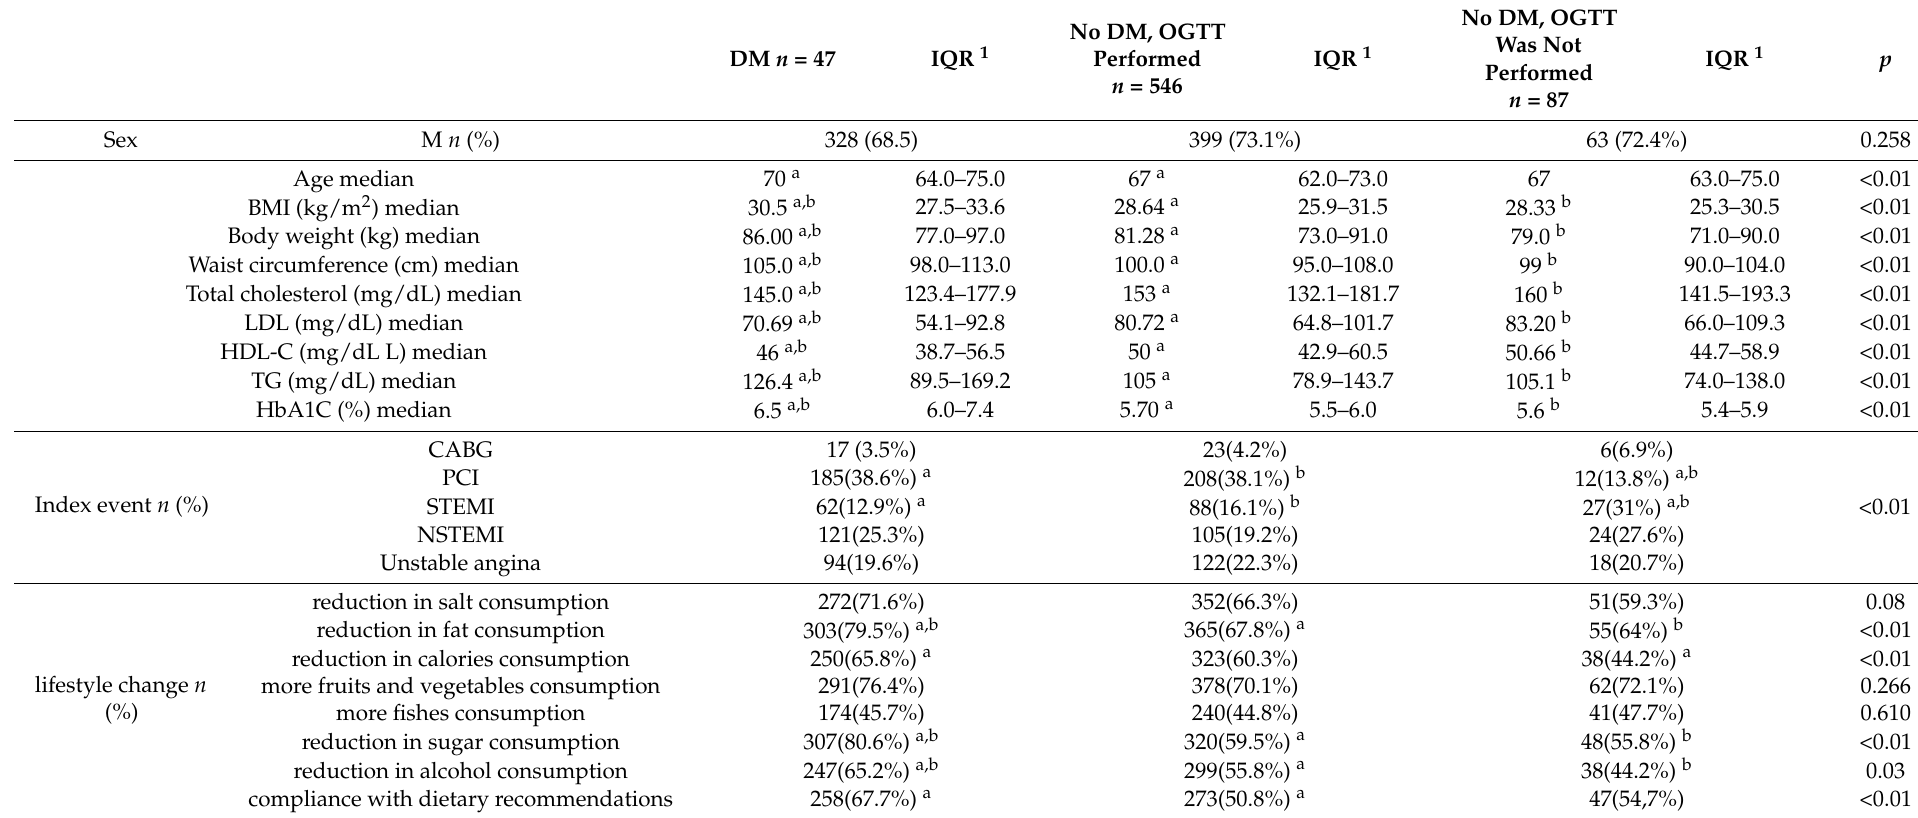
Table 1. Patients’ characteristics with diabetes mellitus (DM) diagnosed before participation in the POLASPIRE study with patients with and without oral glucose tolerance test (OGTT)